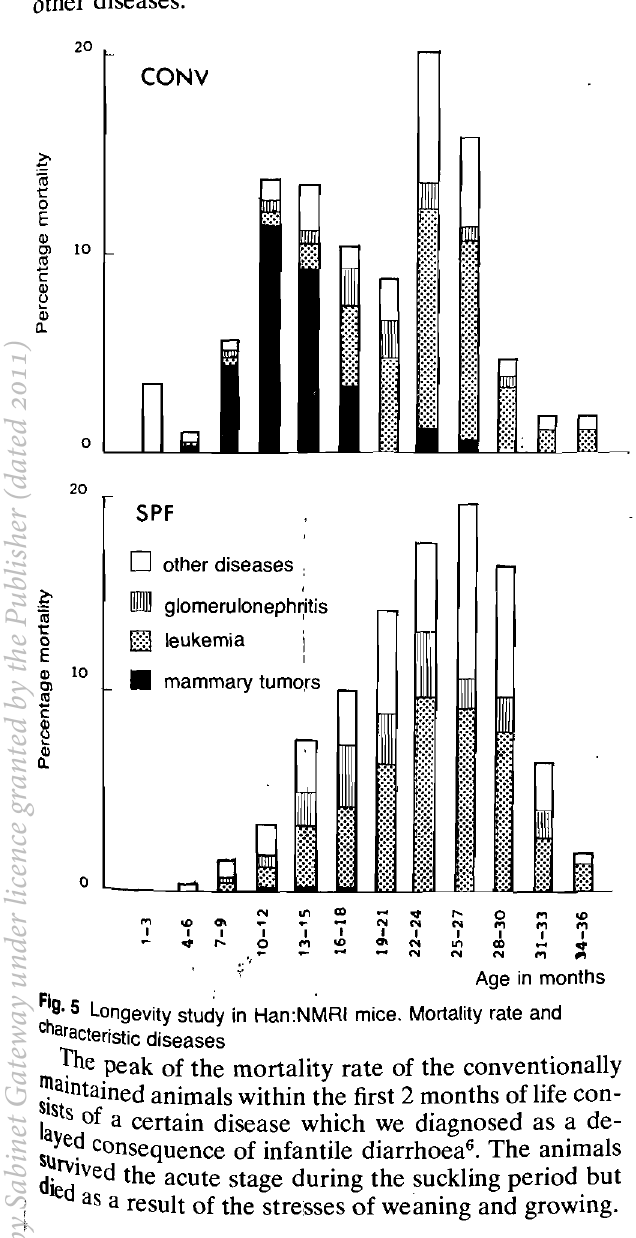
F~9. 5 Longevity study in Han:NMRI mice. Mortality rate and c aracteristic diseases ~he peak of the mortality rate of the conventionally ~alntained animals within the first 2 months of life con die~lved the acute stage during the su~kling period.